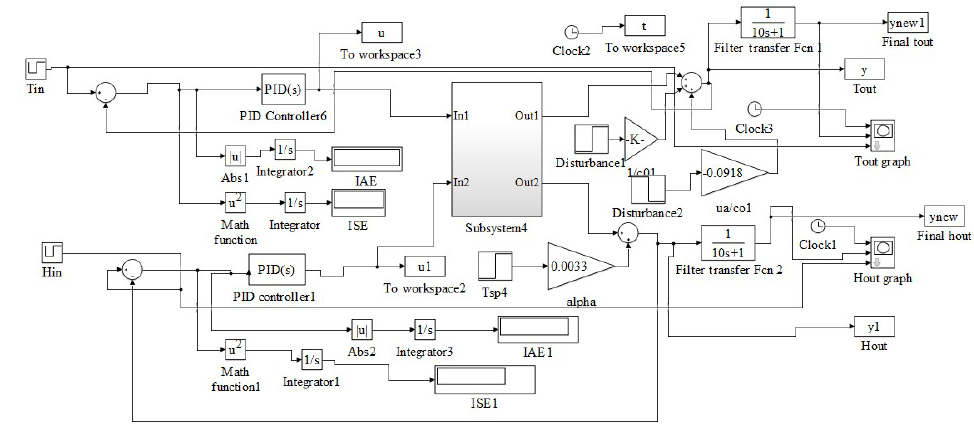
Figure 10. MATLAB/SIMULINK Diagram of Closed-Loop Greenhouse Model with PID